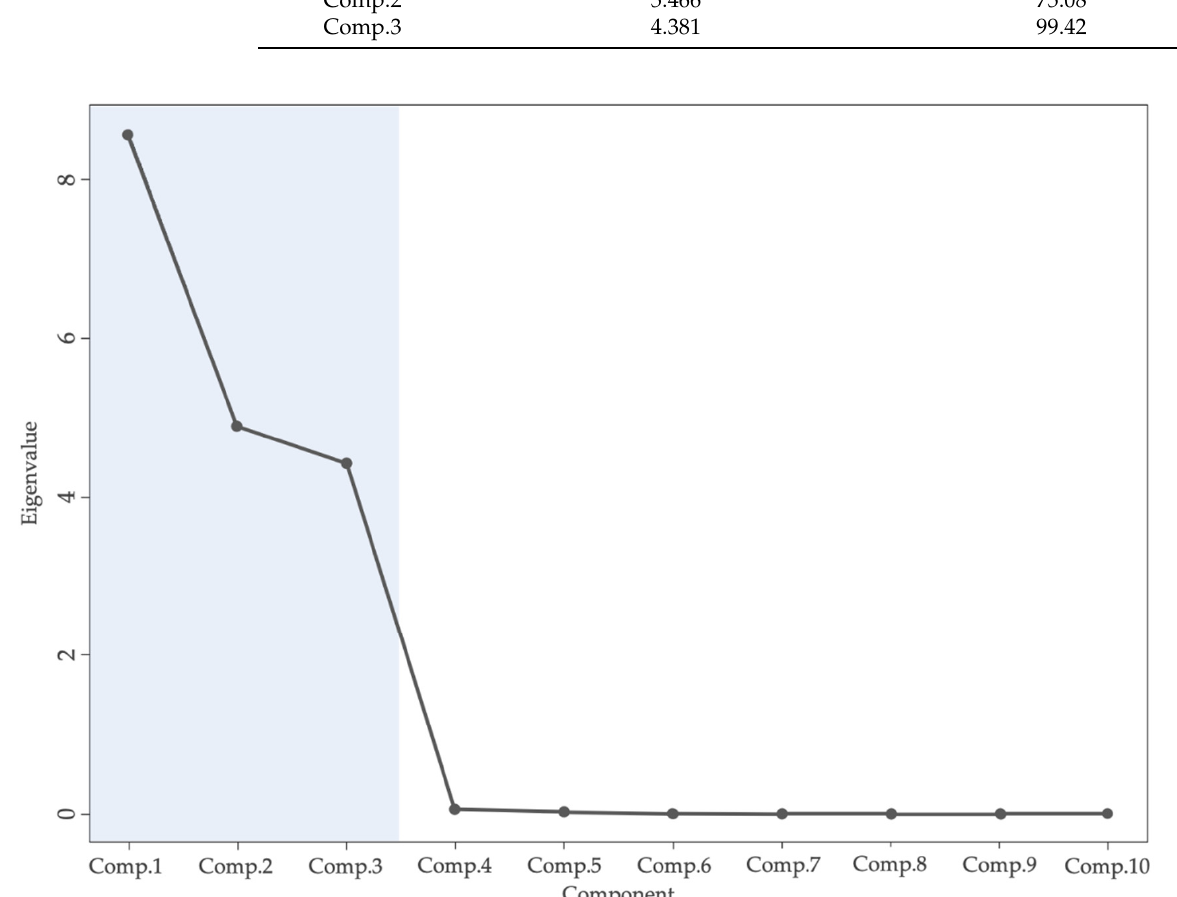
Figure 14. Screen plot of principal components.